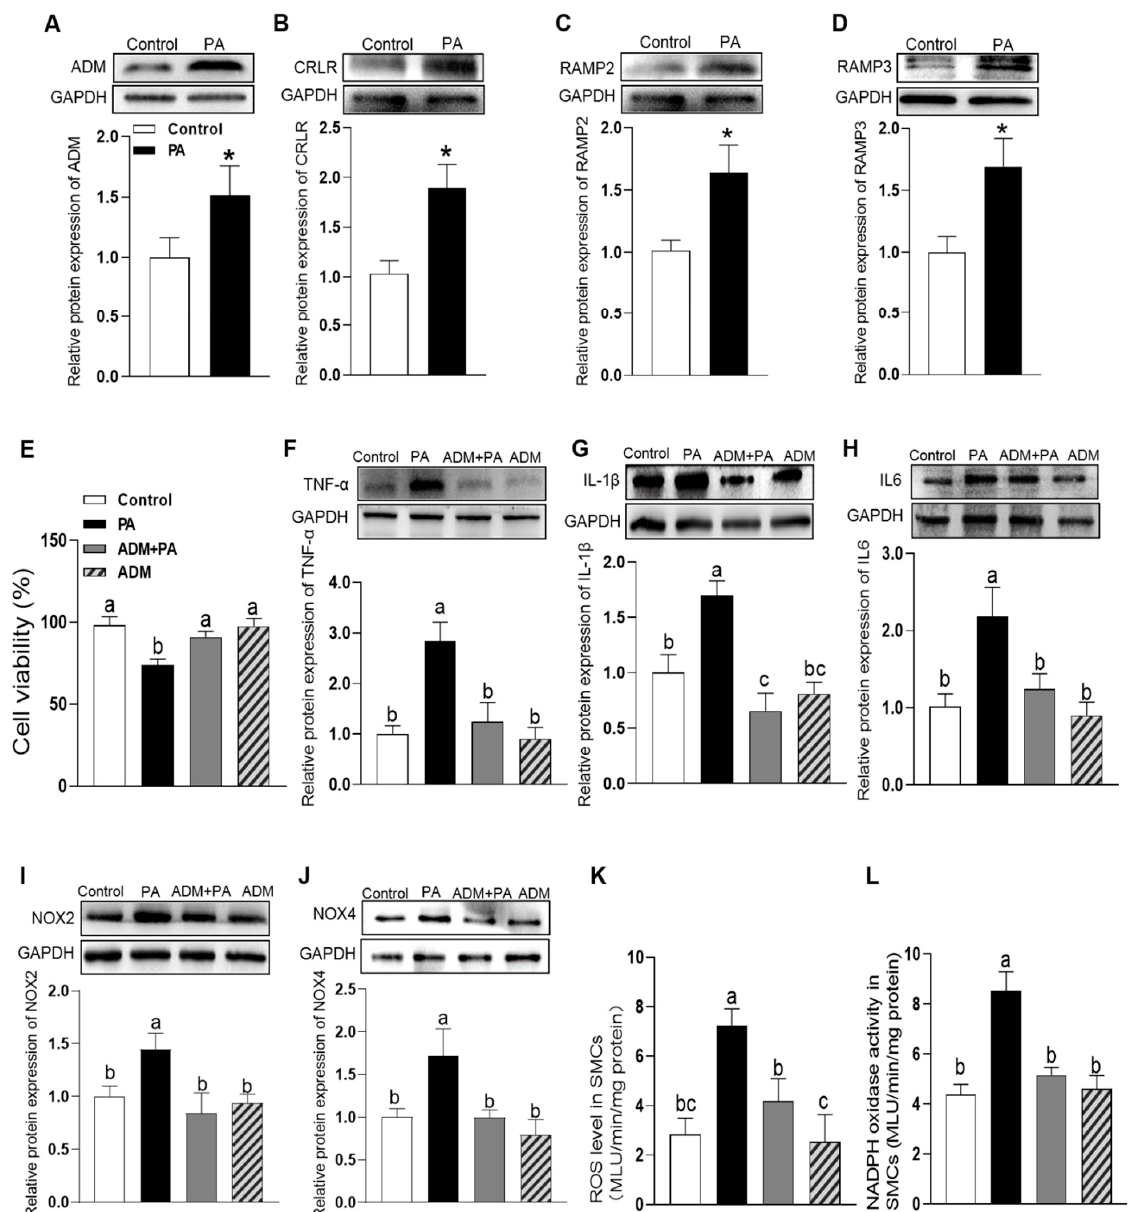
and oxidative stress Figure 6D–H; (all p < 0.0001, Figure 6D–G). Furthermore, ADM ad- ministration also effectively inhibited PA plus Ang II induced-calcification, and which were significantly reversed by ADM22-52 or Compound C. (Figure 7A–E; all p <0.0001, Figure 7A–D). These resuts suggests that receptor-mediated AMPK pathway may involve ADM’s anti-inflammatory, antioxidant and anti-calcification effects in OH state.